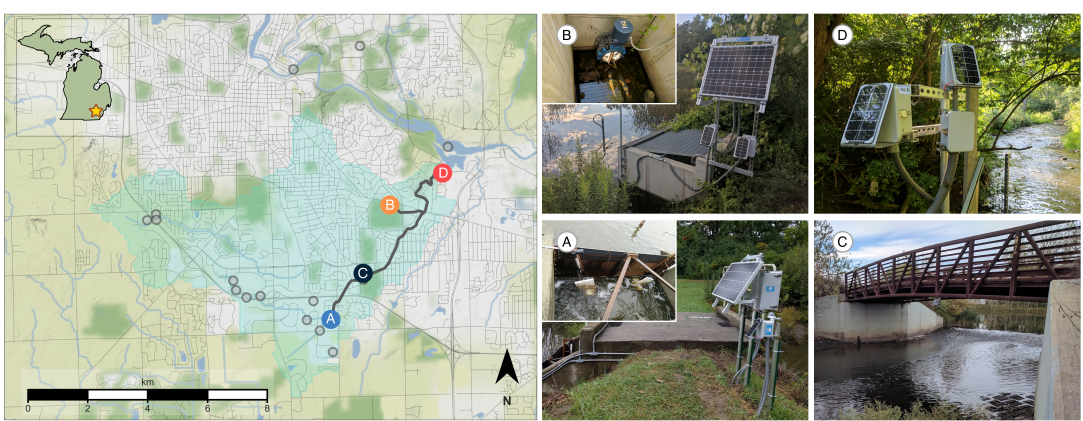
Figure 1. Overview of the study area. The map ( left ) shows the location of relevant control and sensor sites, additional sensor sites (light grey), flow paths between each site (dark grey), and the contributing area of the watershed (light blue). Site images ( right ) show the two control sites ( A & B ) along with two downstream sensor locations ( C & D